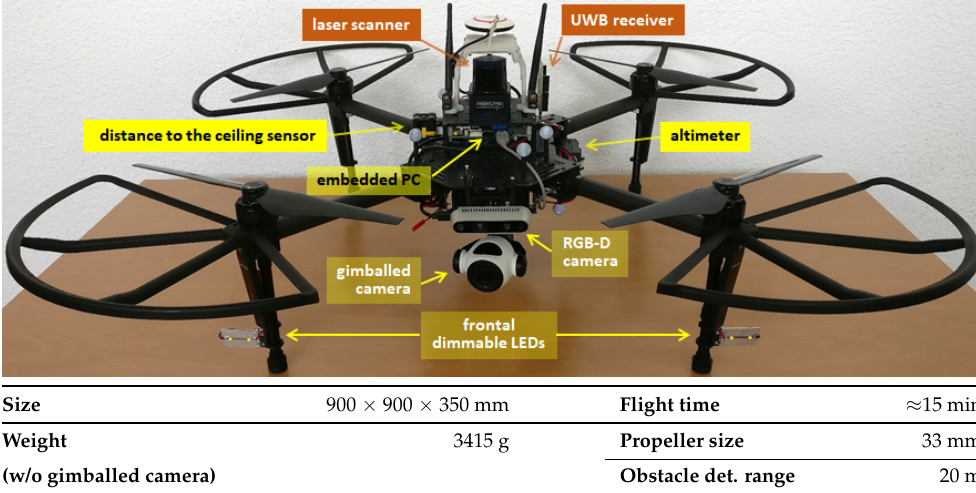
Figure 3. View of the aerial platform with main components highlighted: laser scanner, range finders to measure distance to bottom and to the ceiling, an imaging system with two cameras and LED-based illumination, UWB receiver and an embedded PC. Main specifications are given in the bottom